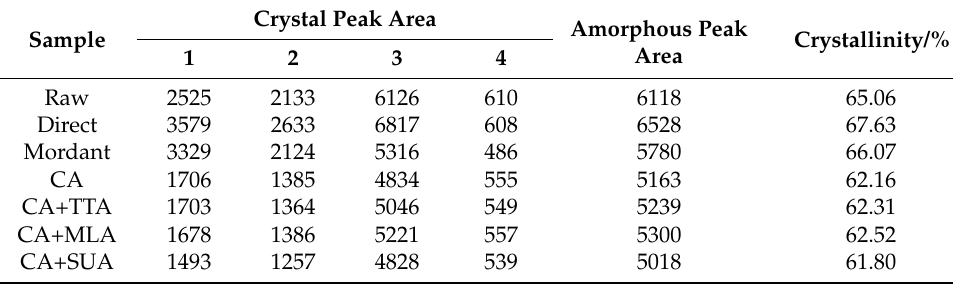
Figure 4. XRD peak-splitting fitting diagrams of the cotton fabrics ( a , raw; b , Direct; c , Mordant; d , CA; e , CA+TTA; f , CA+MLA; g , CA+SUA c), h , X-ray diffraction curves of the cotton fabrics. Table 2. Fitting data and crystallinity of the cotton